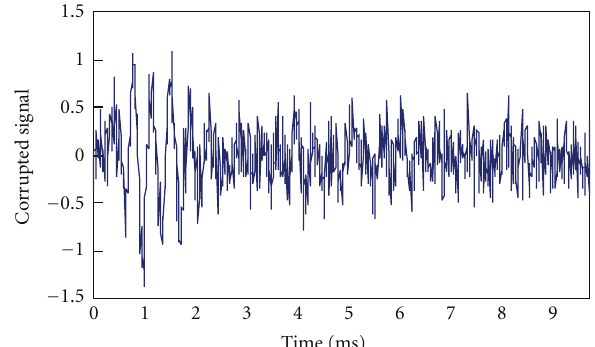
Figure 4: The corrupted version of the signal shown in Figure